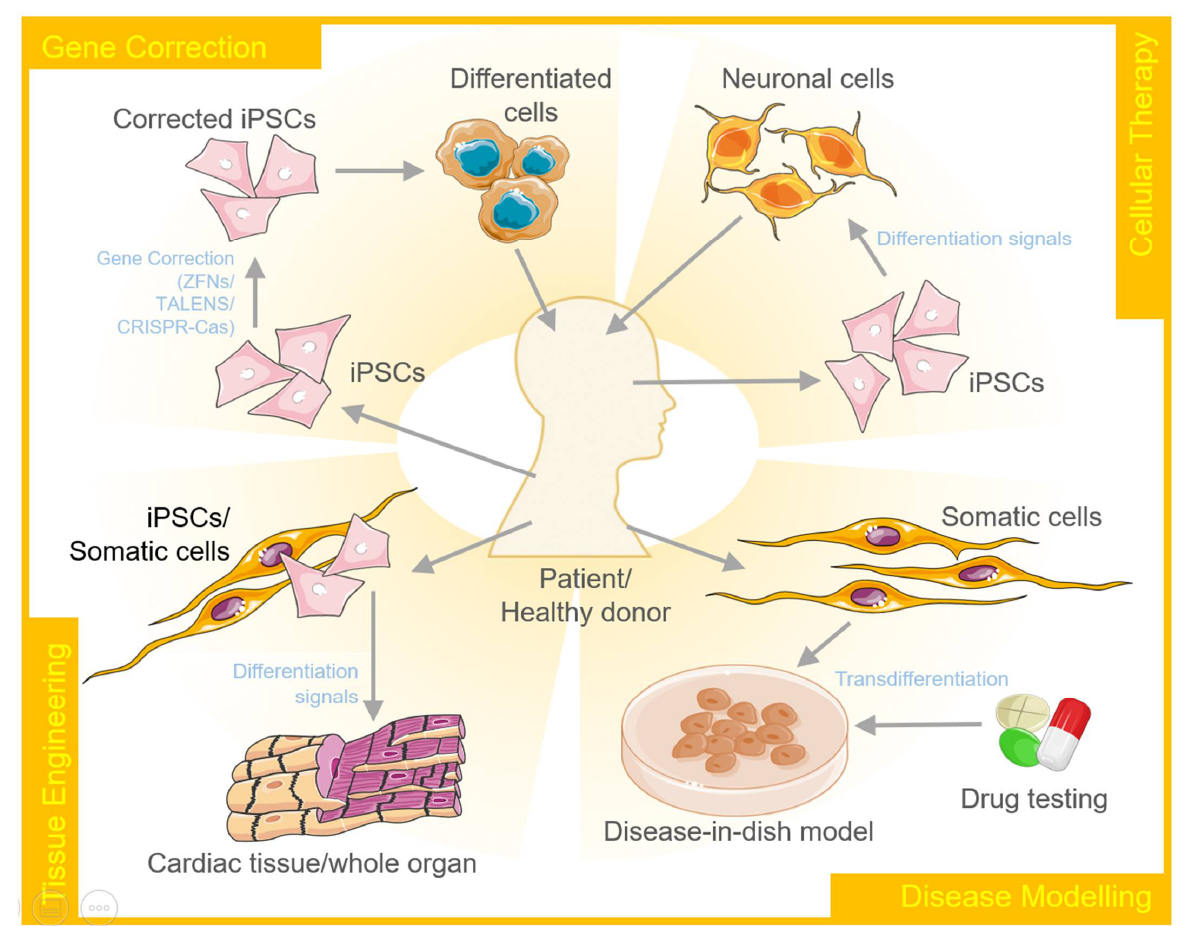
Figure 3. Schematic diagram is showing diverse therapeutic applications of transdifferentiation and cellular reprogramming in gene therapy/correction, cellular therapy, tissue engineering, and disease modeling.